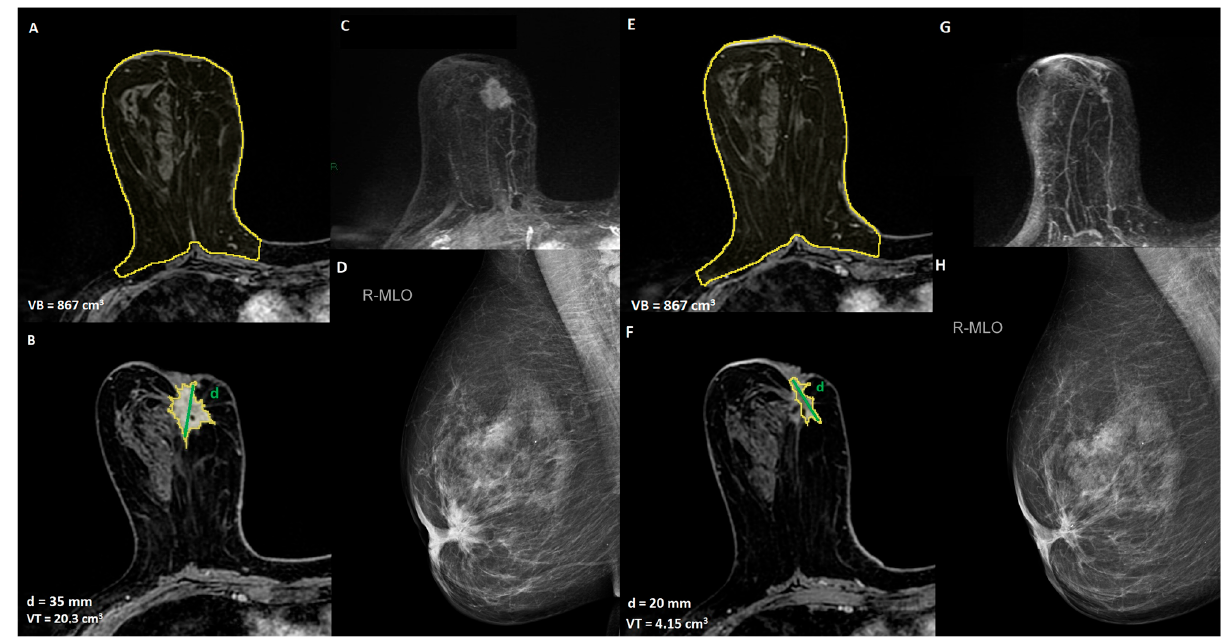
Figure 1. A 52-year-old women with unifocal HER2 positive invasive ductal carcinoma, infiltrating the nipple areola complex, with indication of breast-conservative surgery after NACT: ( A , B ) T1- weighted post-contrast MRI to define the extension of the disease and breast volume, VB = breast volume, VT = tumor volume, d = diameter of the lesion; ( C ) maximum intensity projection (MIP) pre-NACT image; ( D ) mediolateral oblique mammogram of the lesion, ( E , F ) T1-weighted post- contrast MRI to assess the response to NACT, ( G ) maximum intensity projection (MIP) post-NACT image, ( H ) mediolateral oblique mammogram of the lesion post-NACT. In order to optimize oncological and aesthetic outcomes in patients with large or multifocal tumors desiring breast conservation, oncoplastic surgery (OPS) is an option.